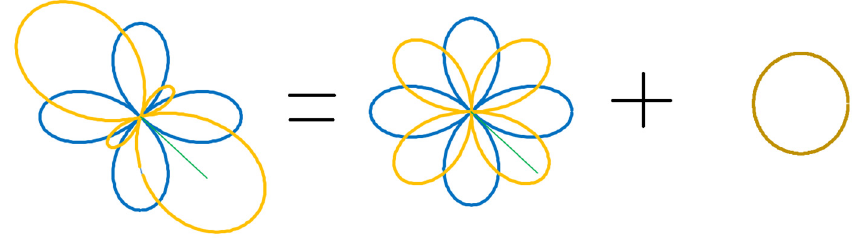
Figure 5. General tensor components rotated by 𝜑 = 32° .